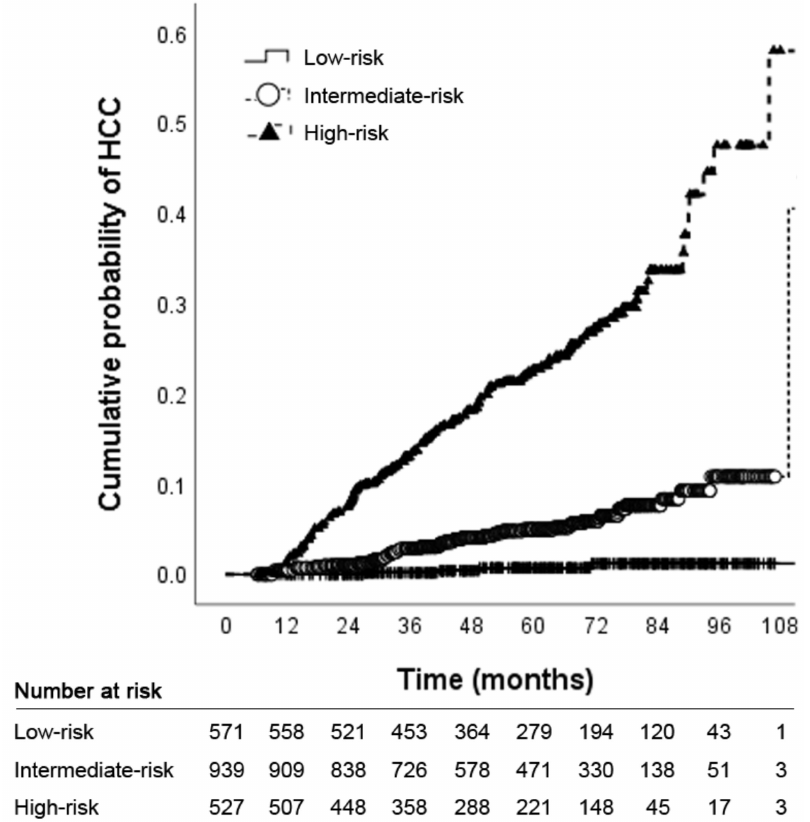
Figure 2. Risk stratification of HCC development according to novel nomogram scores (low-risk, score: ≤ 87; intermediate-risk, score: 88–222; high-risk: ≥ 223; p < 0.001 by log-rank test). HCC, hepatocellular